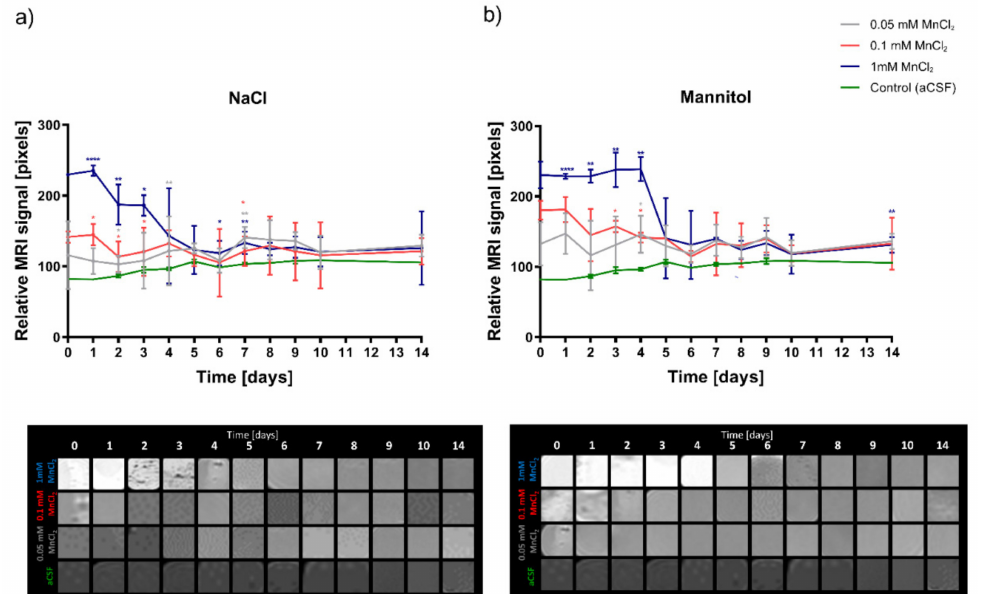
Figure 1. Optimization of the MRI signal of hydrogels in different diluents. ( a ) LVM hydrogels dissolved in 0.9% NaCl, ( b ) LVM hydrogels dissolved in mannitol. Data are expressed as mean with standard deviation (SD) and differences were considered as statistically significant at the 95% confidence level (* p < 0.05, ** p < 0.01, **** p < 0.0001).